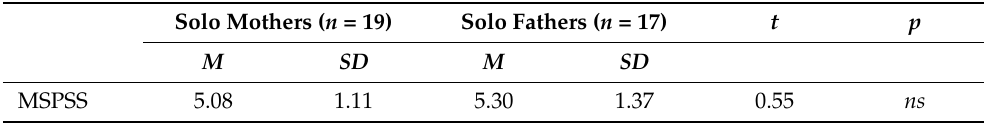
Table 5. Means, SDs, t and p values for comparisons of mothers’ and fathers’ scores on the Multidi- mensional Scale of Perceived Social Support.